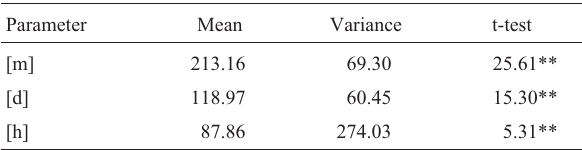
Table1 -Additivedominantmodelgeneticeffectsestimatesfortheparen- tal (P 1 , P 2 ), filial (F 1 , F 2 ) and backcross (BC 1 , BC 2 ) generations of the to- mato cross ‘Santa Clara’ x BGH 6902. The estimates were based on the